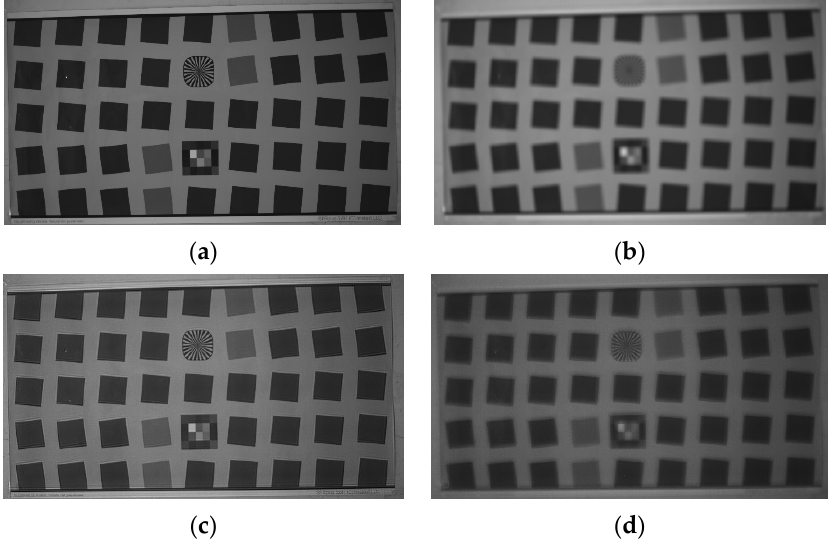
Figure 5. Experimental results of conventional imaging system and wavefront coding imaging system under defocus conditions, ( a ) image of conventional imaging system in focusing state; ( b ) decoded image of conventional imaging system under 10 units defocus amounts; ( c ) image of wavefront coding system in focusing state; ( d ) decoded image of wavefront coding system in 10 units positive defocusing state.